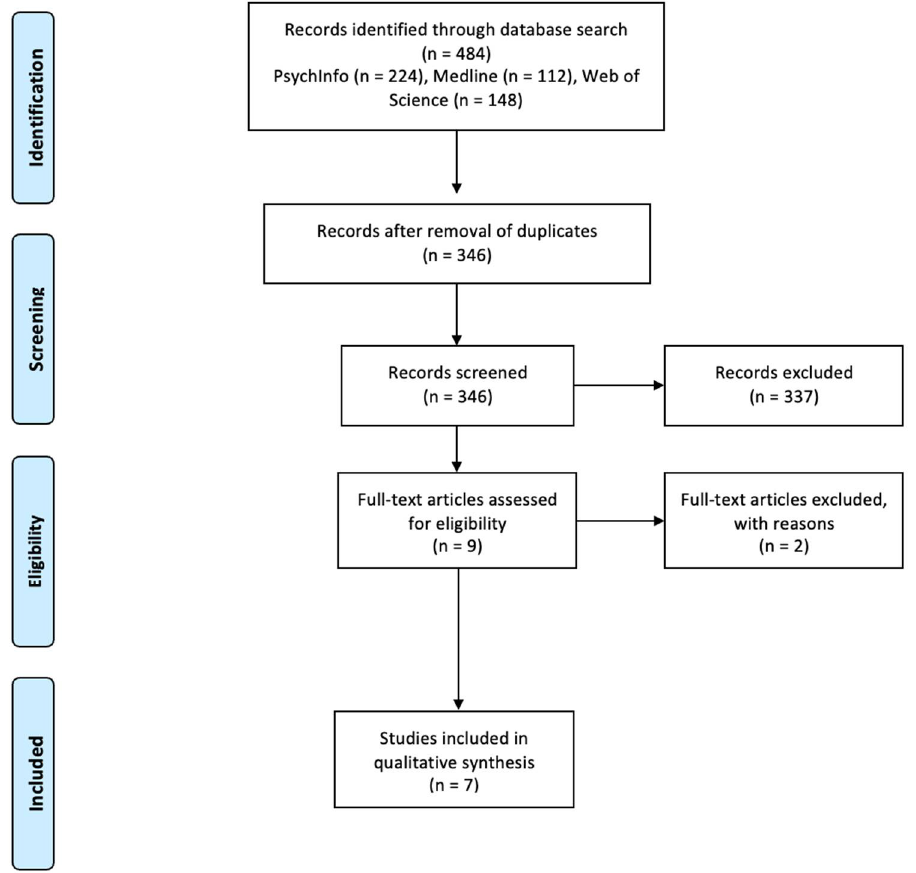
Figure 1. Flow diagram of the database search.